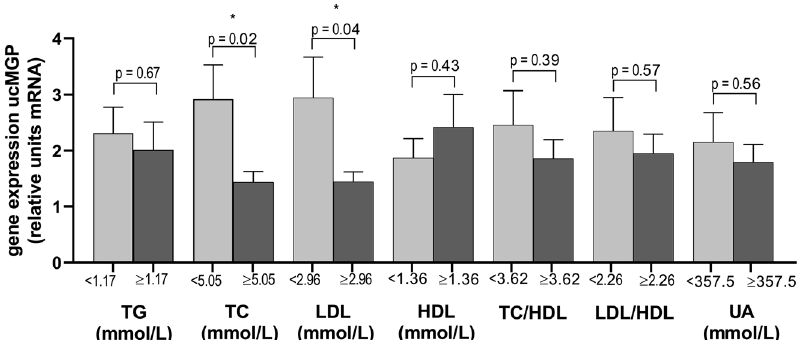
Figure 4: MGP expression levels in PBMC according to metabolic risk factors for CVD. Data are presented as mean ± standarderror of mean (SEM).Gene expression is calculatedwith the 2 − ΔΔ Ct methodwherethe value of mRNA in the calibrator group (n=9) is considered to be equal to 1. Median value for each parameter was considered as a cut-off value for subgroup statistics analysis. Triglycerides (TG), total cholesterol (TC), LDL-cholesterol, HDL-cholesterol and uric acid (UA) are presented as mmol/L.